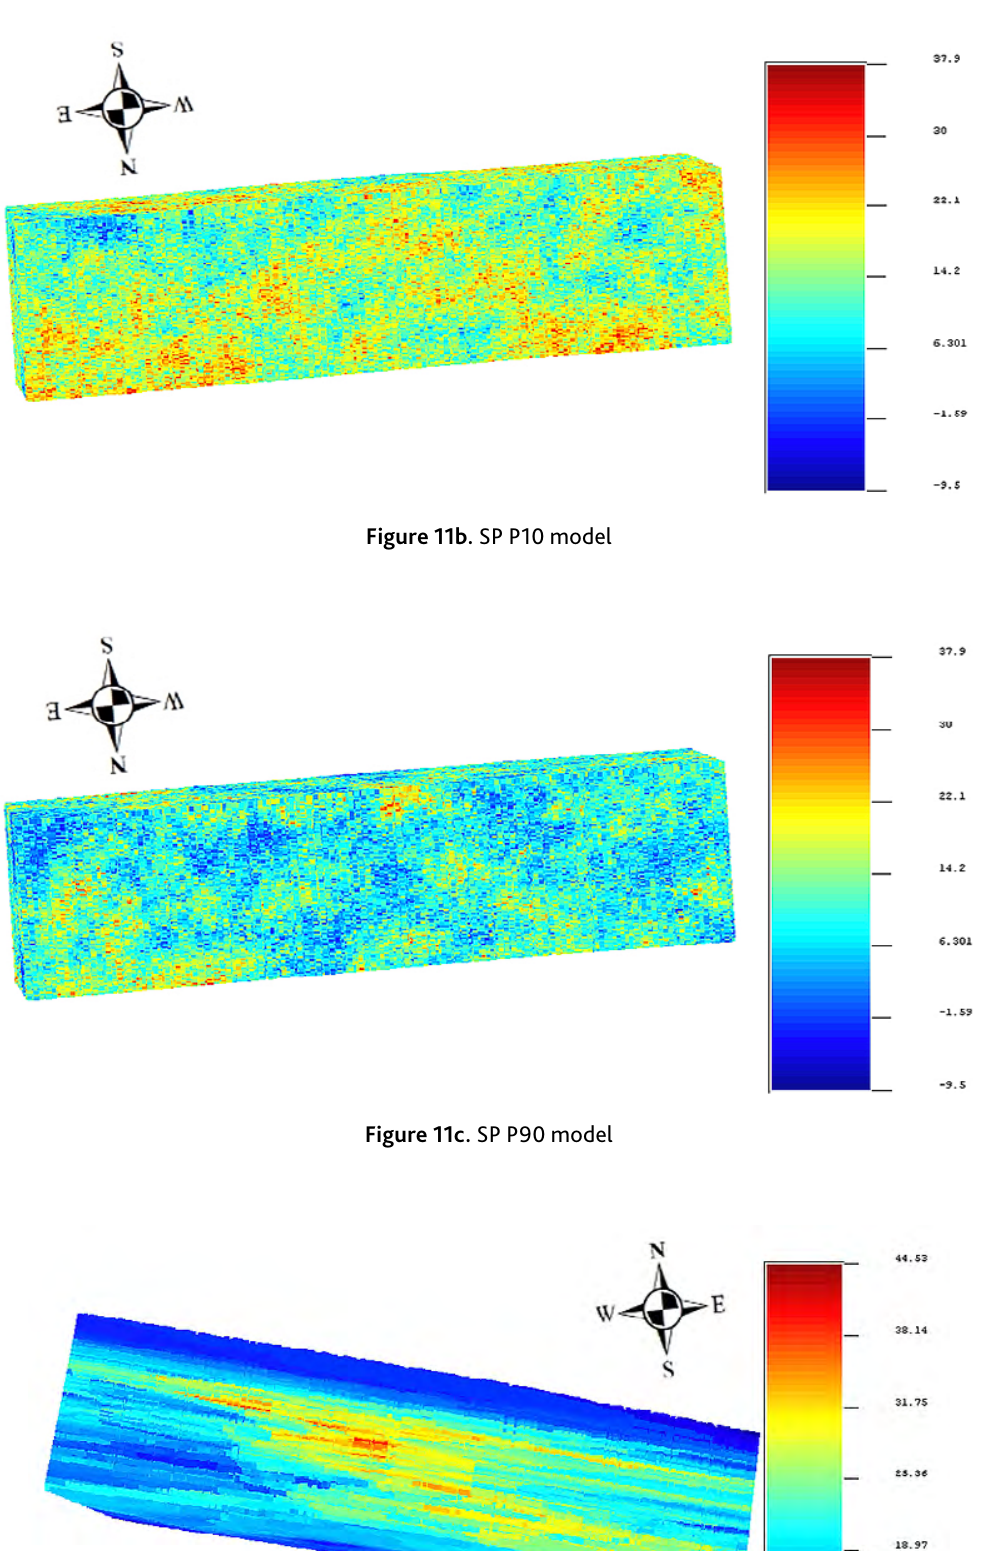
Figure 12a. R kriging map